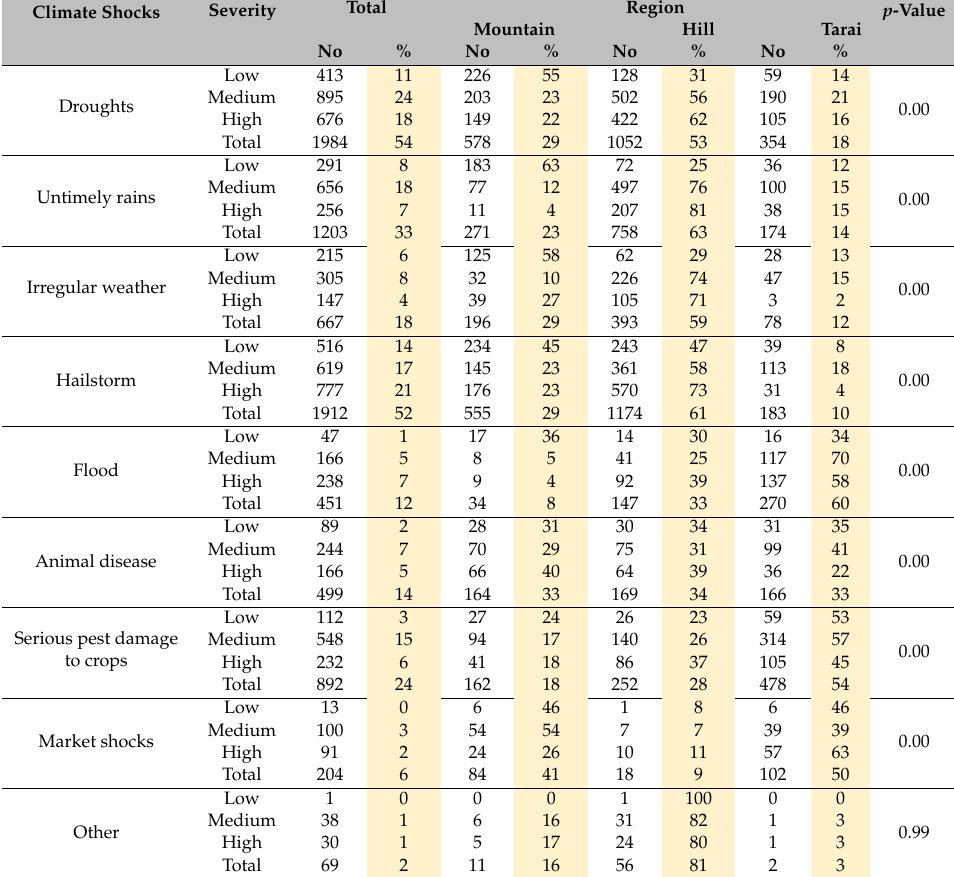
Table A5. Perceived impacts of the climate shocks as per ecological regions. Climate Shocks